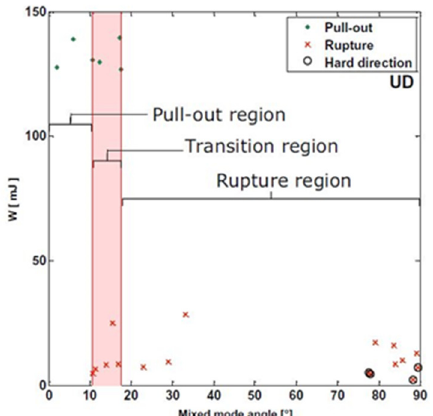
F igure 23 . Effect of mode mixicity angle on Figure 24. E ff ect of mode mixicity angle on single z-Pin failure (CFRP z-Pin, d = 0.28 mm, [0] pre-preg) [31].